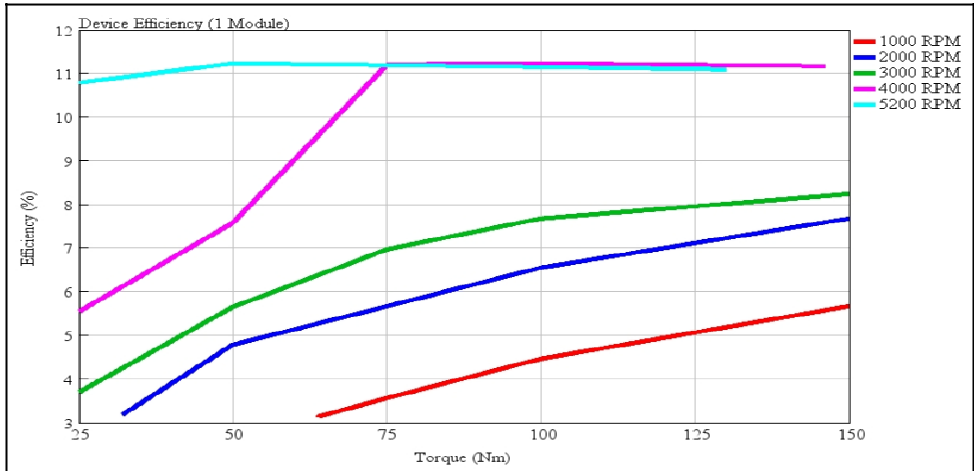
Figure 14. Device efficiency of 1 module (25 mm × 25 mm).